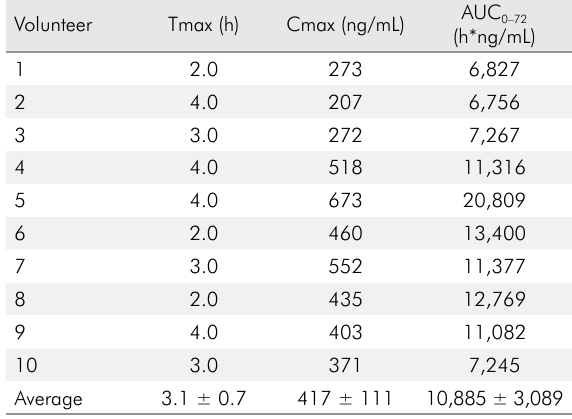
Table. Pharmacokinetic parameters of piroxicam concentrations in the human plasma of each